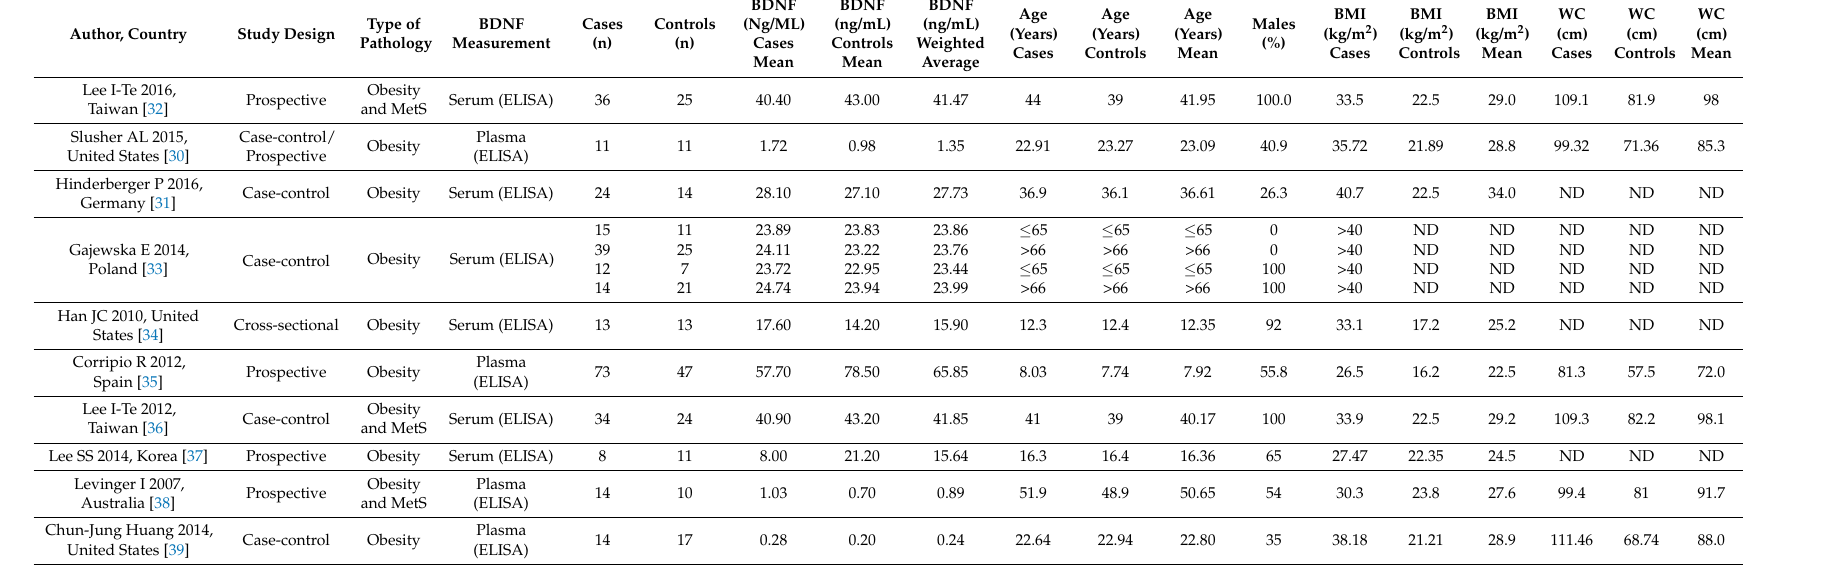
Table 1. Demographic and clinical data of obese patients and healthy controls of the included